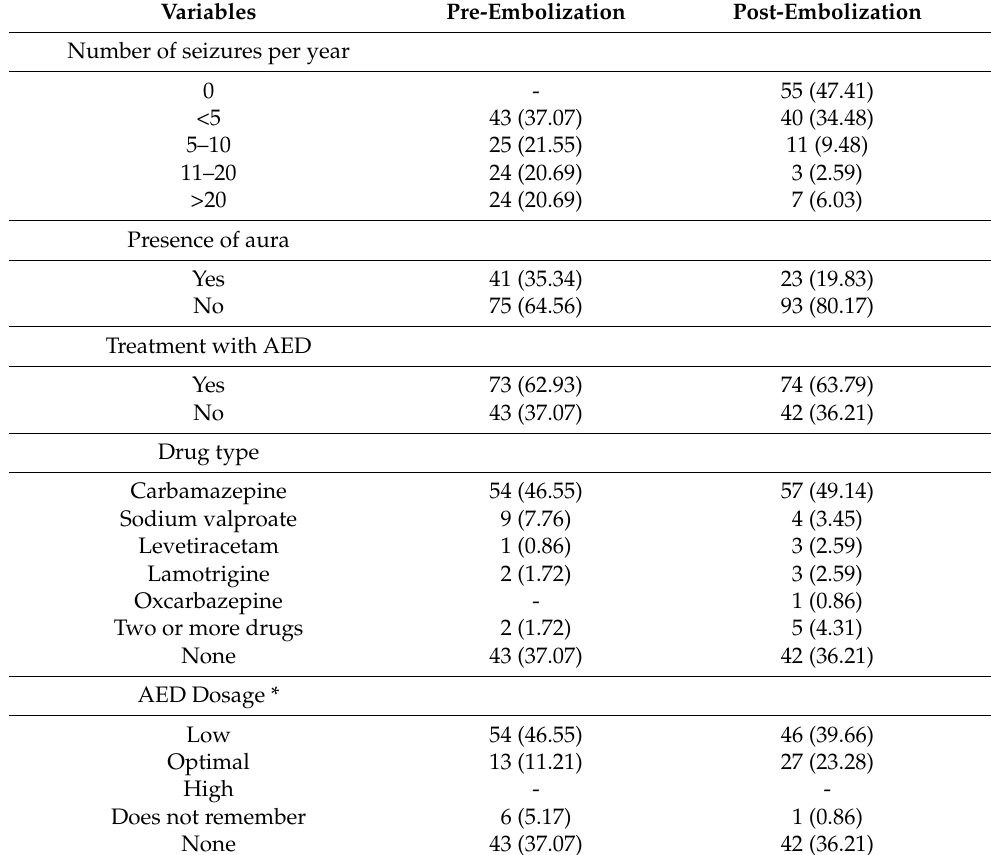
Table 2. Seizure manifestation and management pre- and